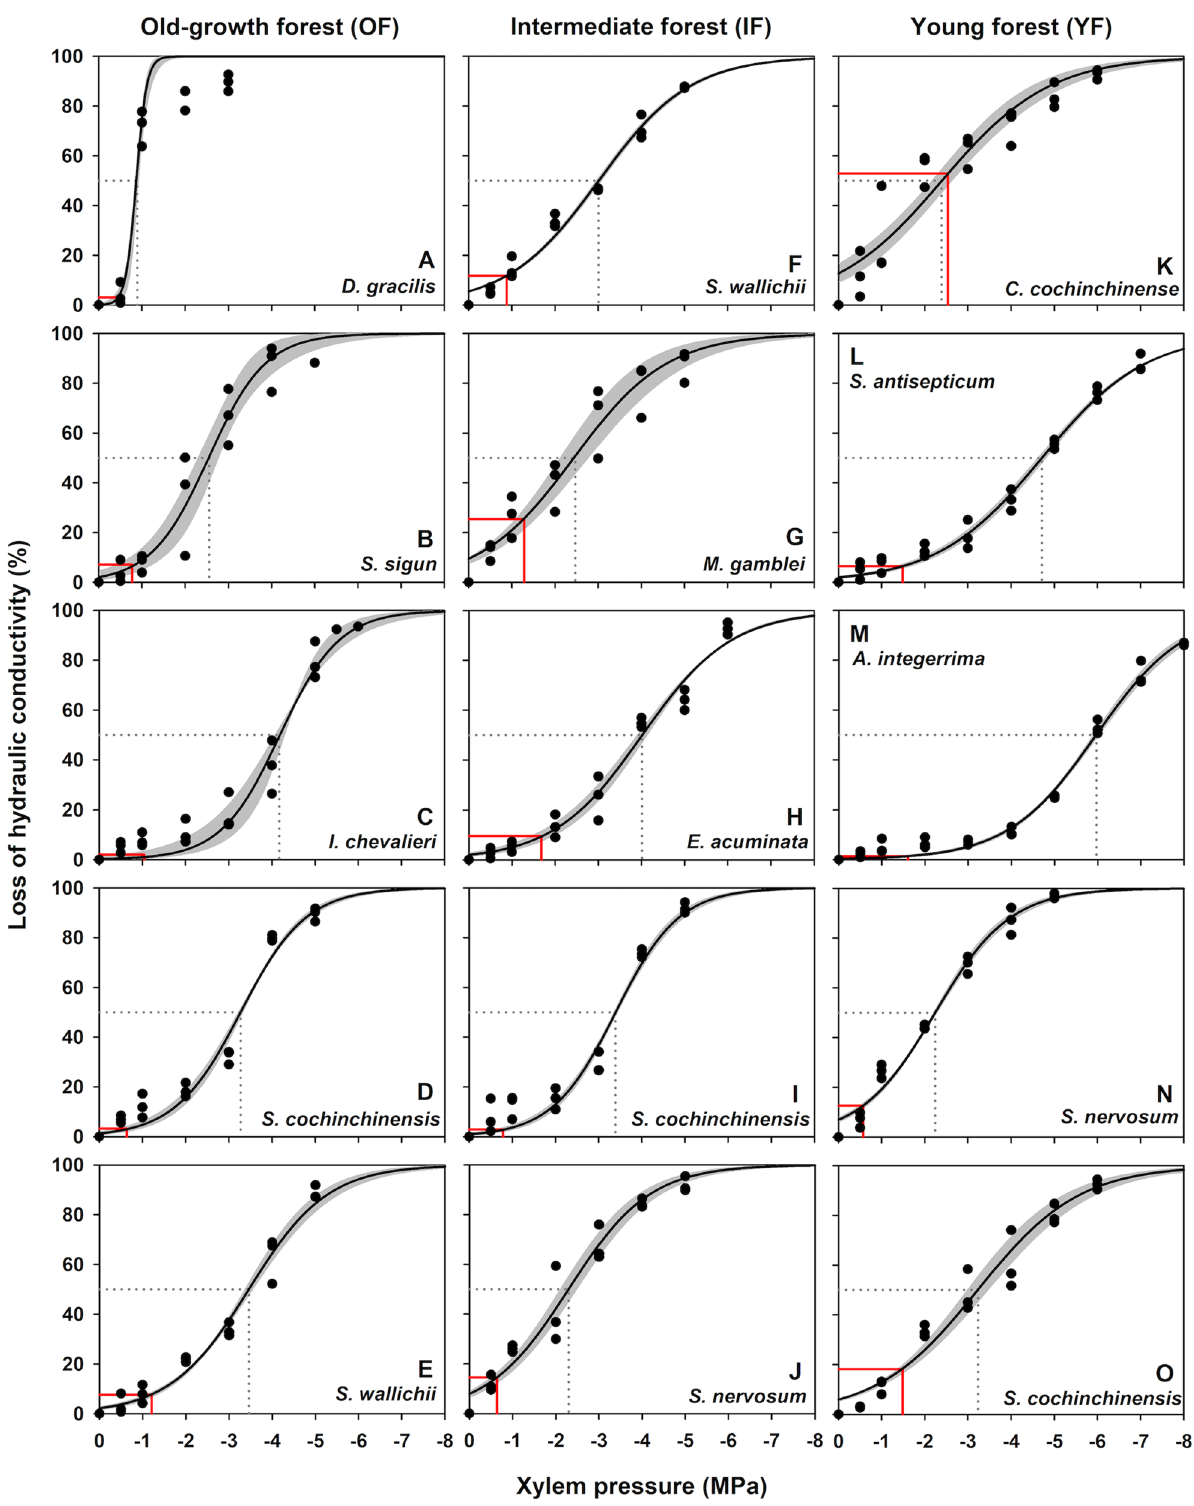
Figure 3. Vulnerability of xylem to embolism of branches from dominant tree species from different successions in Khao Yai National Park, Thailand. Mean vulnerability curves are presented with shaded bands representing one standard error from 3 measured branches for a given species. The gray dotted and solid red lines indicate the xylem pressure at 50% loss of hydraulic conductivity (P 50 ) and percentage loss of hydraulic conductivity corresponding to midday leaf water potential (Ψ md ) during the dry season (PLC dry ),